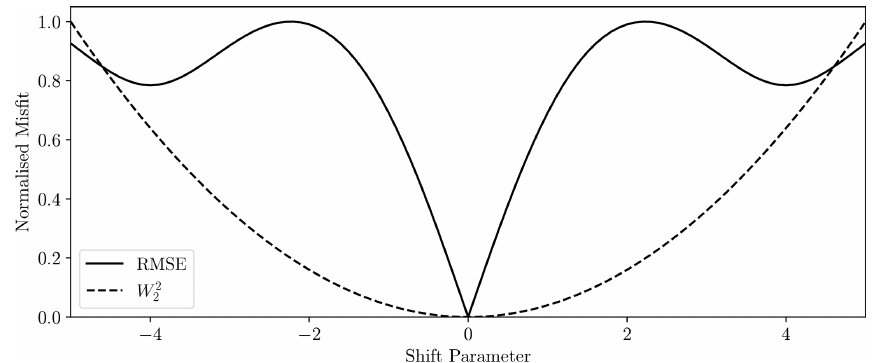
Figure 5. Comparison of RMSE and squared 2-Wasserstein distance for the double-Gaussian problem displayed in Fig. 3. All misfits are scaled to a maximum of 1 for visualisation